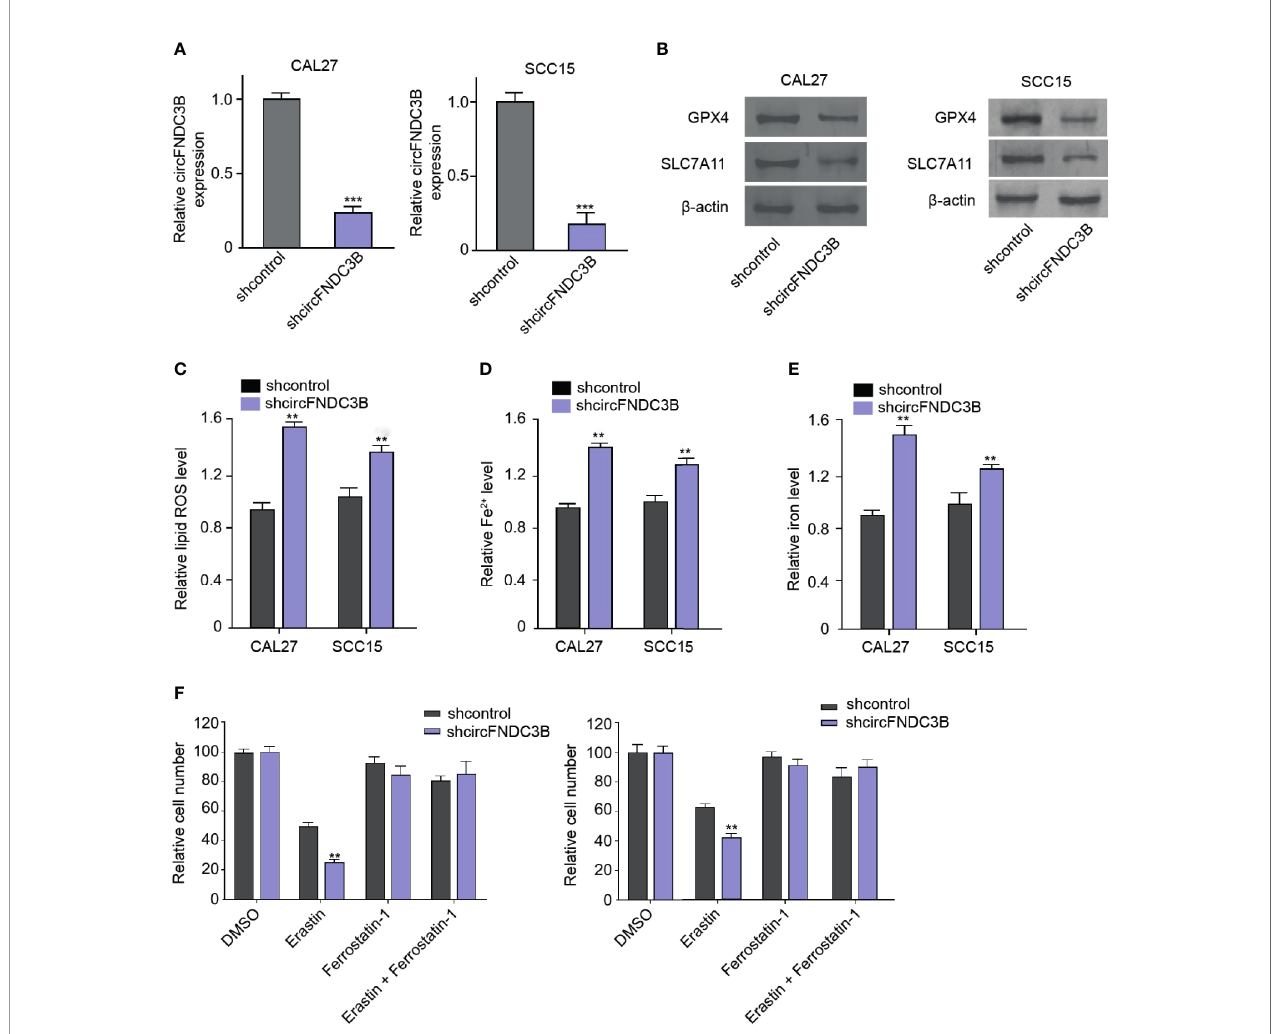
FIGURE 1 | CircFNDC3B protects OSCC cells against ferroptosis. (A – F) The circFNDC3B shRNA treated the CAL27 and SCC15 cells. (A) The RT-qPCR analysis of circFNDC3B expression. (B) Western blot of GPX4 and SLC7A11 expression. (C – E) Analysis of ROS, iron, and Fe 2+ levels. (F) CCK-8 assays of cell viability. N = 3, mean ± SEM: ** P < 0.01, *** P <